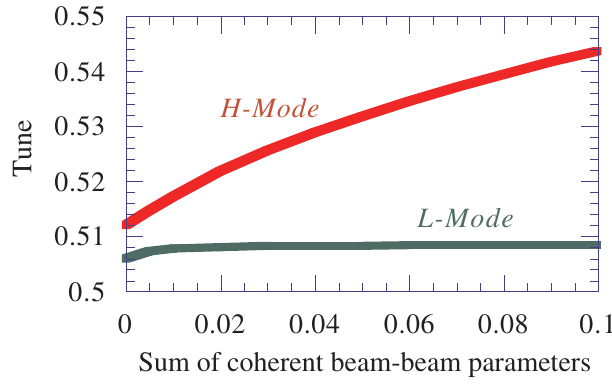
FIG. 3. (Color) H -mode and L -mode tunes as a function of sum of the coherent beam-beam parameters, where unperturbed frac- (cid:5) 0 : 506 and (cid:4) (cid:2) (cid:5) 0 : 512 . tional tunes are (cid:4) (cid:7) 0 0